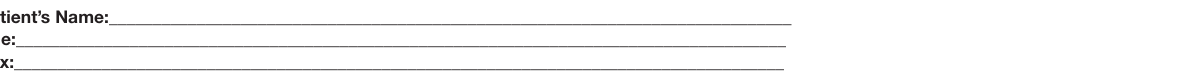
TABLE 6 | Risk factors concerning rheumatoid arthritis patients before